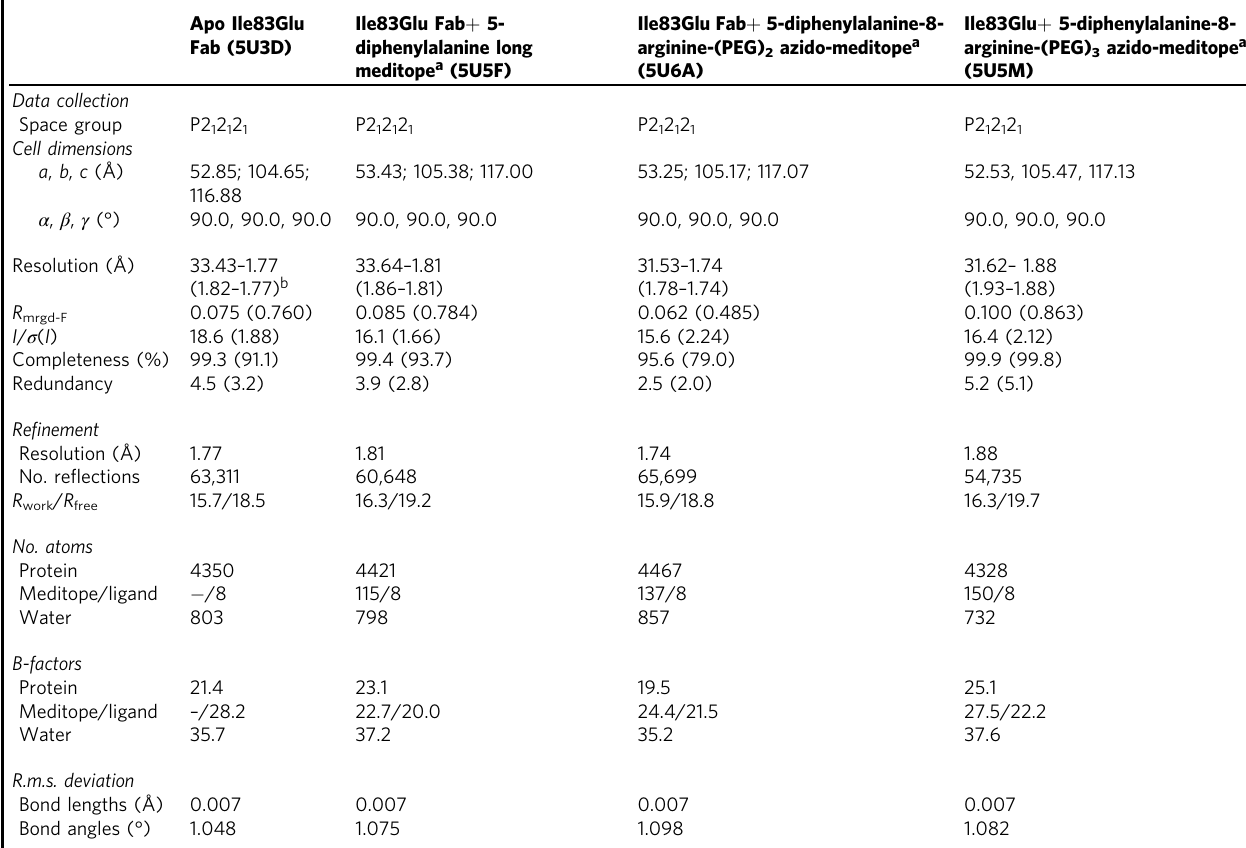
Table 1 Data collection and re fi nement